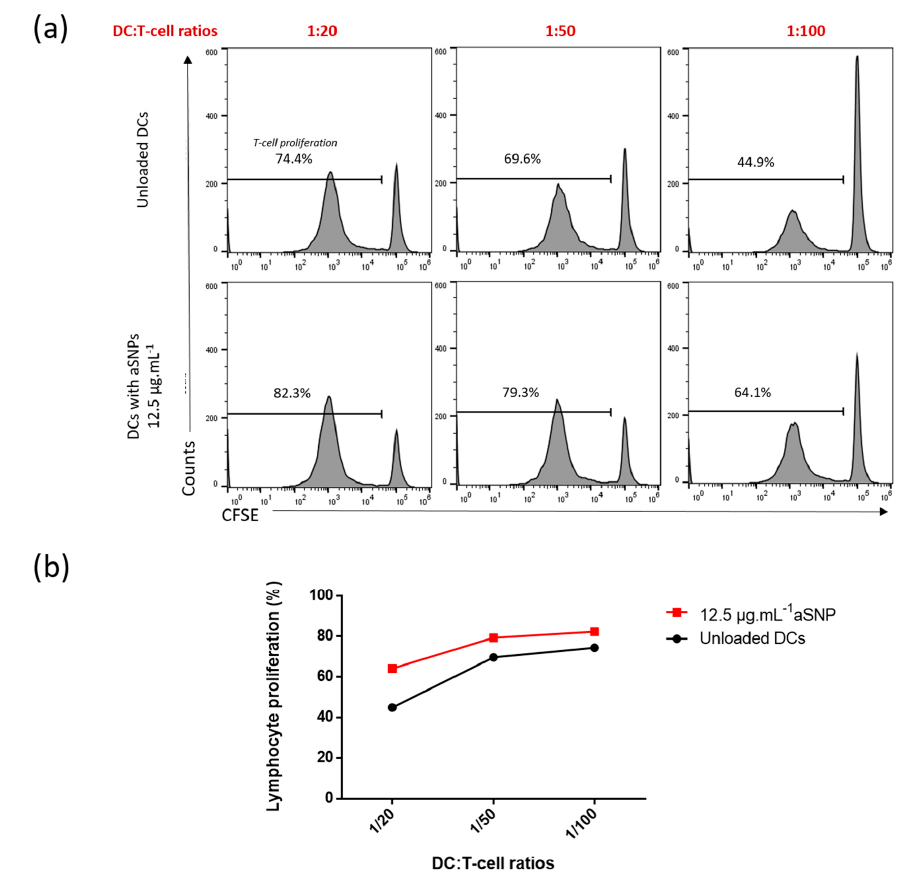
Figure 5. Low ratios allowed a better visualization of the increase in lymphocyte proliferation after 6 days of co-culture . Cells were incubated in the presence or absence of 12.5 µg.mL − 1 of aSNP for 16 hours. Treated MoDCs were co-cultured with allogeneic CD4+ T-cells labeled with CFSE at a ratio of 1:20 (1 moDC for 20 CD4+ T-cells), 1 : 5 0 and 1 :100). Proliferation was quantified after 6 days of co- culture as the percentage of CFSE low CD4+ T-cells. Untreated DCs were used as negative